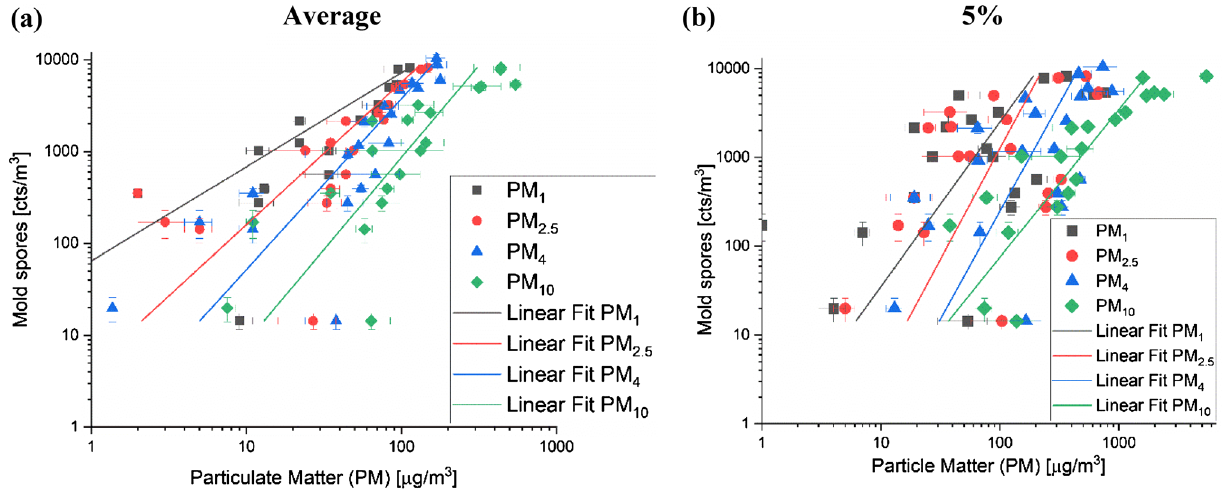
Fig. 6 Relationship between the counts of the mold spores and the particulate matter. Particulate matter (PM) are divided into four groups, PM with an average diameter lower than 10 (PM